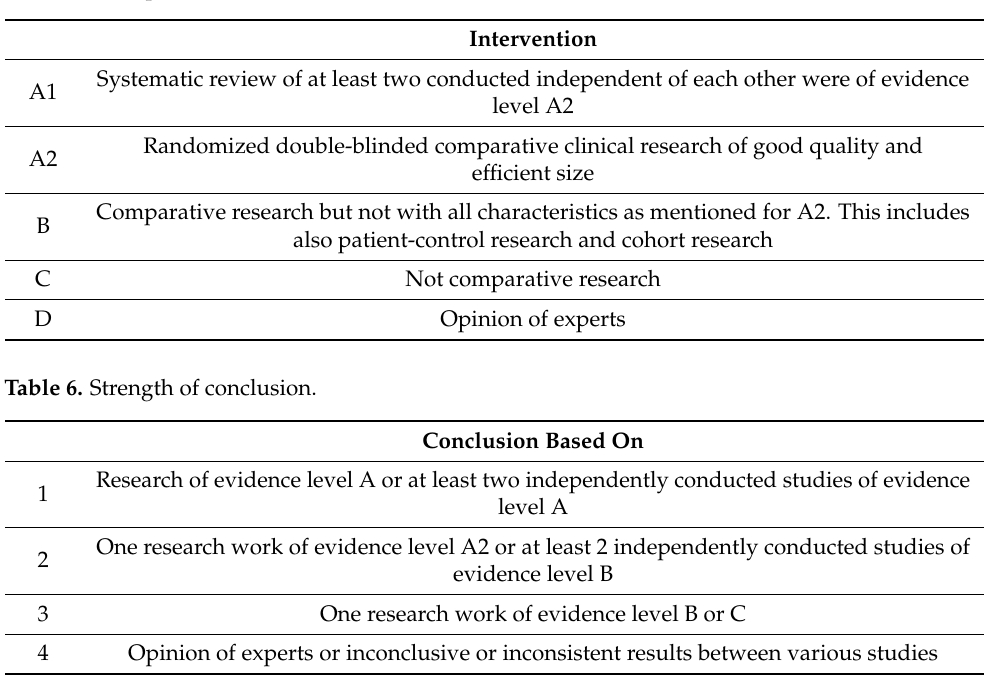
Table 5. Level of evidence according to the 2005 classification system of the Dutch Institute for Healthcare Improvement CBO.